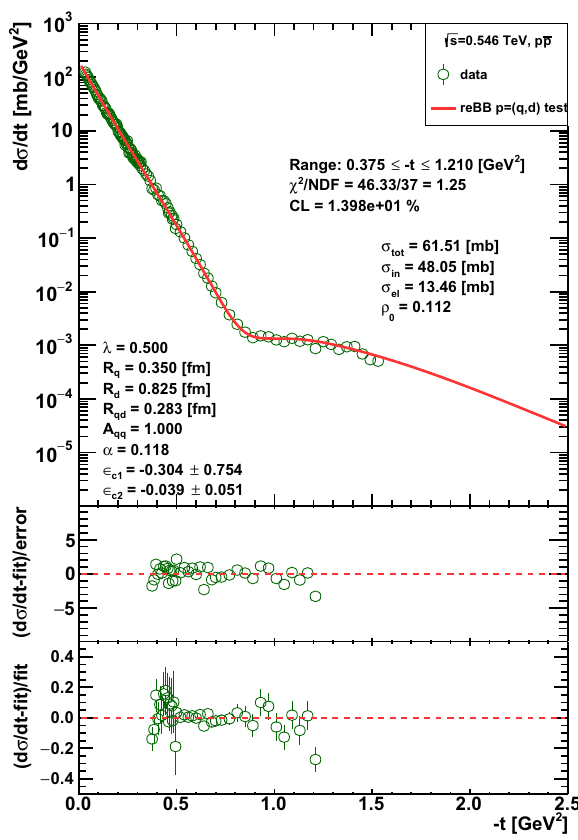
Fig. 8 Resultofthesanitytestforthe0.546TeV p ¯ p elasticdifferential cross section data [48,49] in the range of 0 . 37 ≤ − t ≤ 1 . 2 GeV 2 . This sanity test was performed as a fit during which the model parameters R q , R d , R qd and α were fixed to their s -dependent value based on Table 2, while correlation coefficients (cid:6) -s in the χ 2 definition, Eq. (6), were fitted as free parameters. Thus the physical parameters R q , R d , R qd and α are printed on the plot without error bars while the fitted correlation coefficients are given with their errors. The best parameter values are rounded up to three valuable decimal